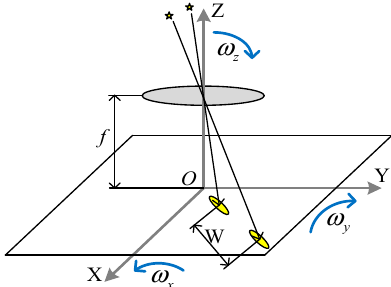
Figure 4. Calculating principle of matching window.